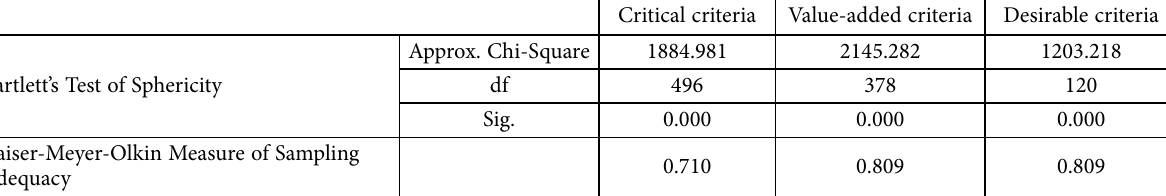
Table 3. Bartlett’s Test of Sphericity and KMO test results Critical